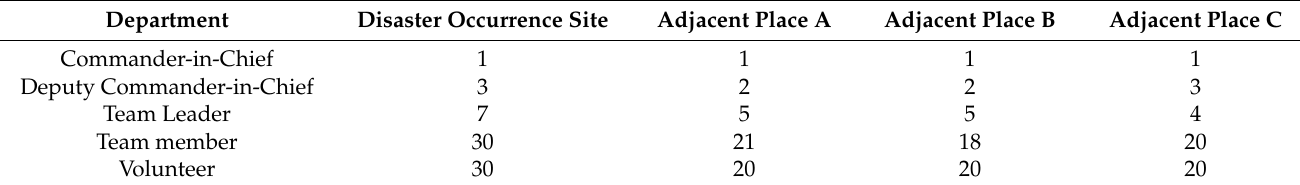
Table 2. Personnel information of each management department (person).